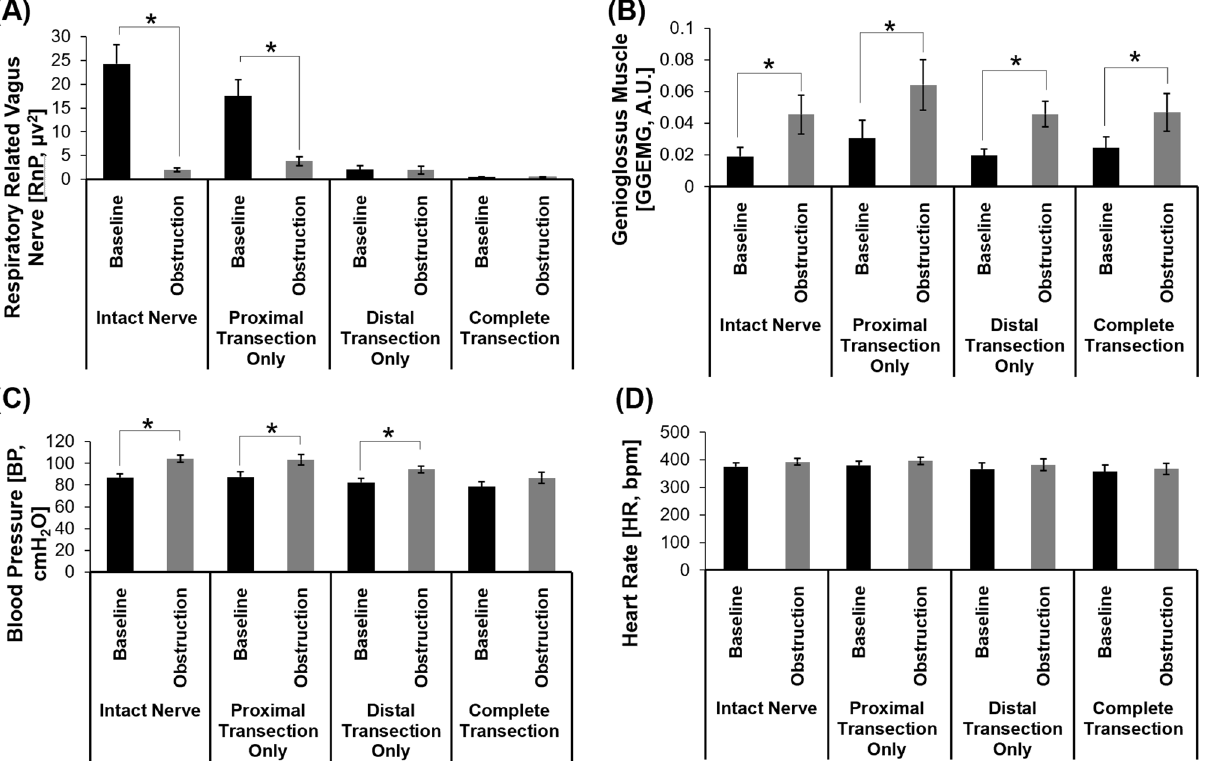
Figure 2. Summary of the effects of airway obstruction on different cases including (1) the intact nerve, (2) the transected nerve at the proximal end, (3) the transected nerve at the distal end, and (4) the transacted nerve at both ends. Analysis was performed for on all physiological parameters including ( A ) respiratory-related vagus nerve profiles (RnP), ( B ) genioglossus muscle activity (GGEMG), ( C ) blood pressure (BP), and ( D ) heart rate (HR). [*, p value < 0.05 compared to the baseline, n =